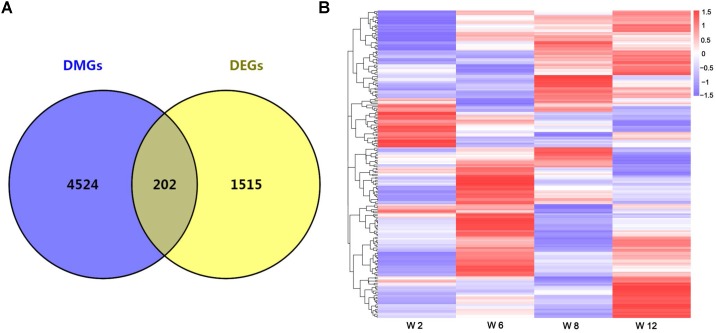
(A) The number of overlap genes between DMGs and DEGs is shown by a Venn diagram. (B) Cluster analysis of overlap genes between DMGs and DEGs according to the methylation levels of genes. Red indicated hypermethylation levels and purple indicated hypomethylation levels.